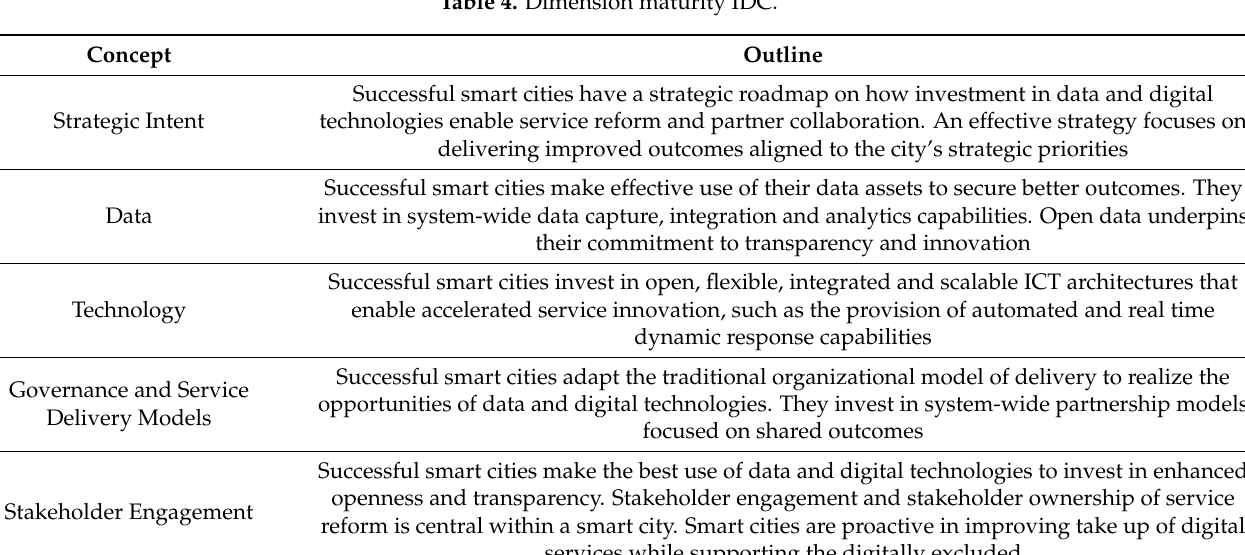
Table 4. Dimension maturity